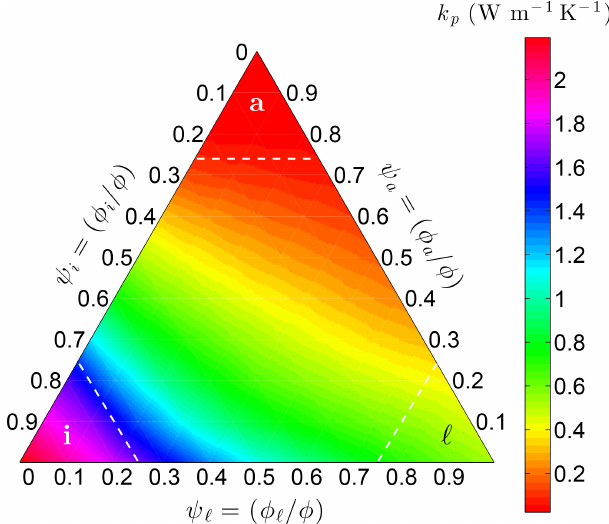
Figure 5. Variation of the pore thermal conductivity k p on Earth at − 10 ◦ C with the relative volume fractions of liquid water ( ψ (cid:96) ), ice ( ψ i ), and air ( ψ a ) within the pores. Threshold α is 0.75 in this